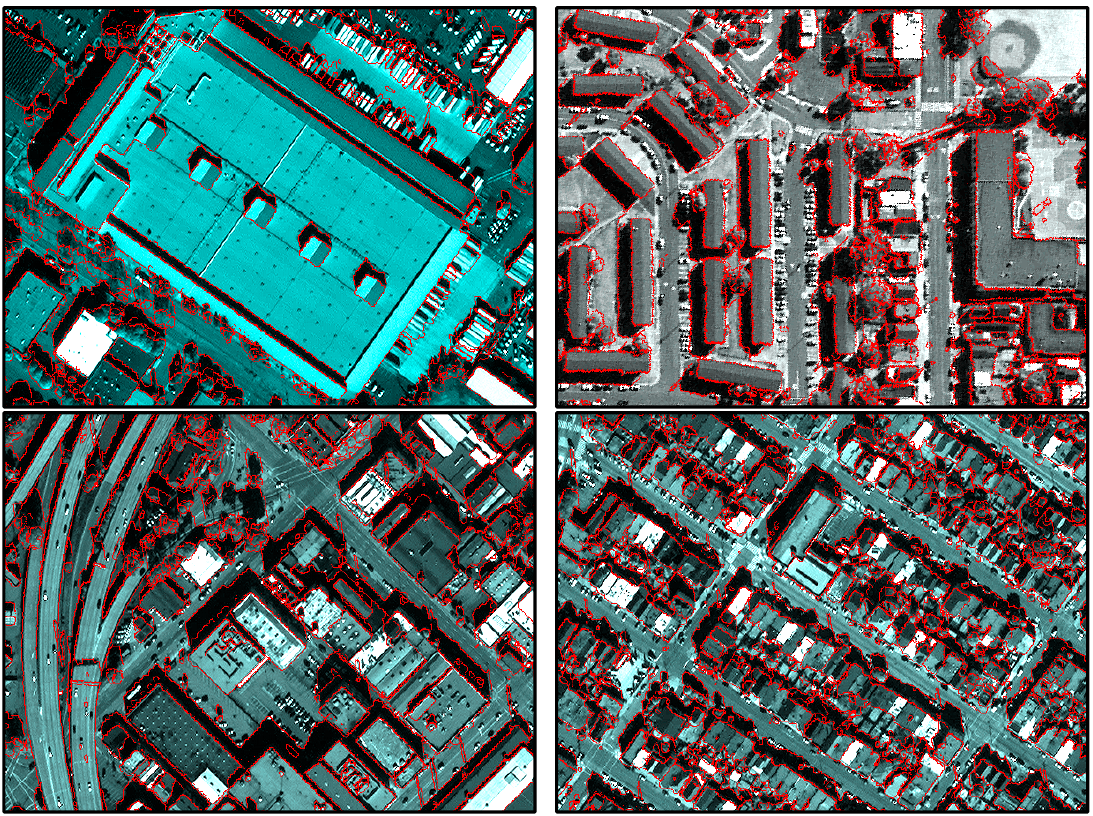
Figure 26. Projected LiDAR and shadow edges transformed and superimposed on the HRSI via the fine 3D model. fine 3D